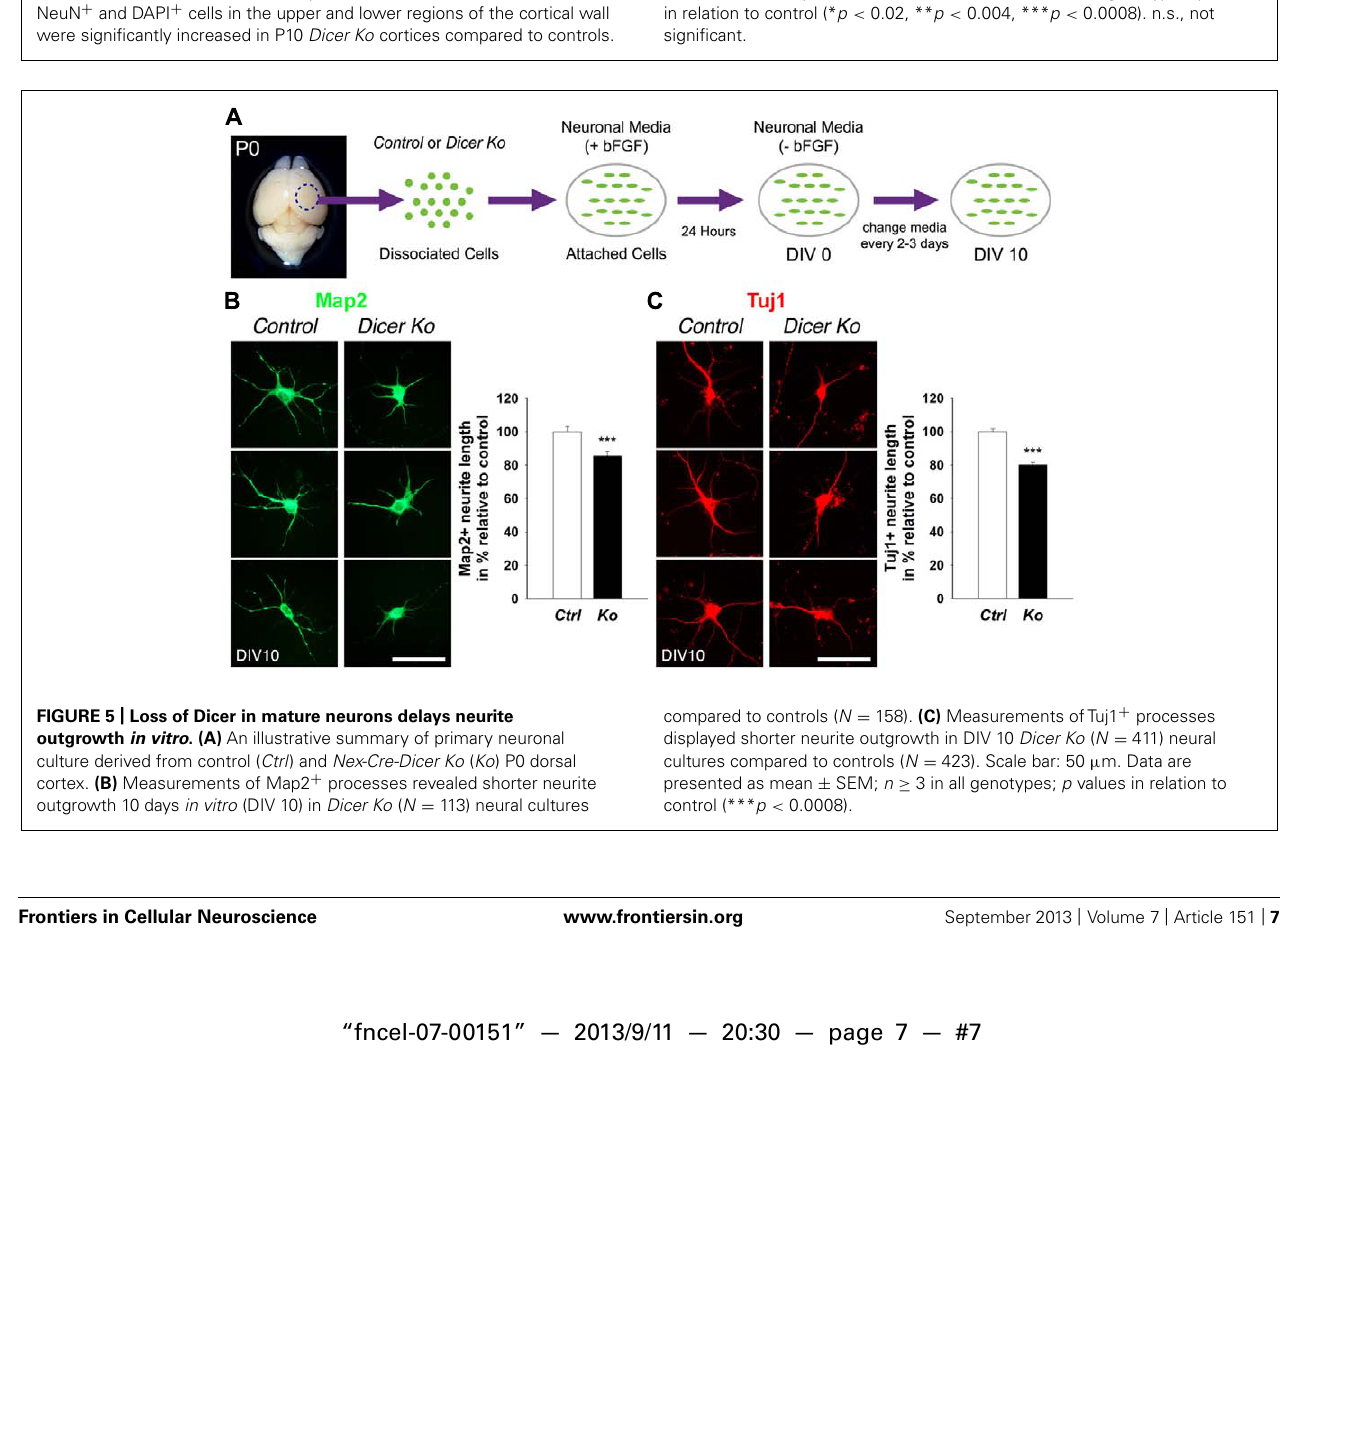
The dashed boxes indicate the region shown at higher magnification in panel i (cid:2) , i (cid:2)(cid:2) , ii (cid:2) , ii (cid:2)(cid:2) ; the boxed area in this region was chosen for subsequent analysis. The ventricular surface (vs) and pial surface (ps) are labeled. Scale bar: 100 μ m. Data are presented as mean ± SEM; n ≥ 3 in all genotypes; p values